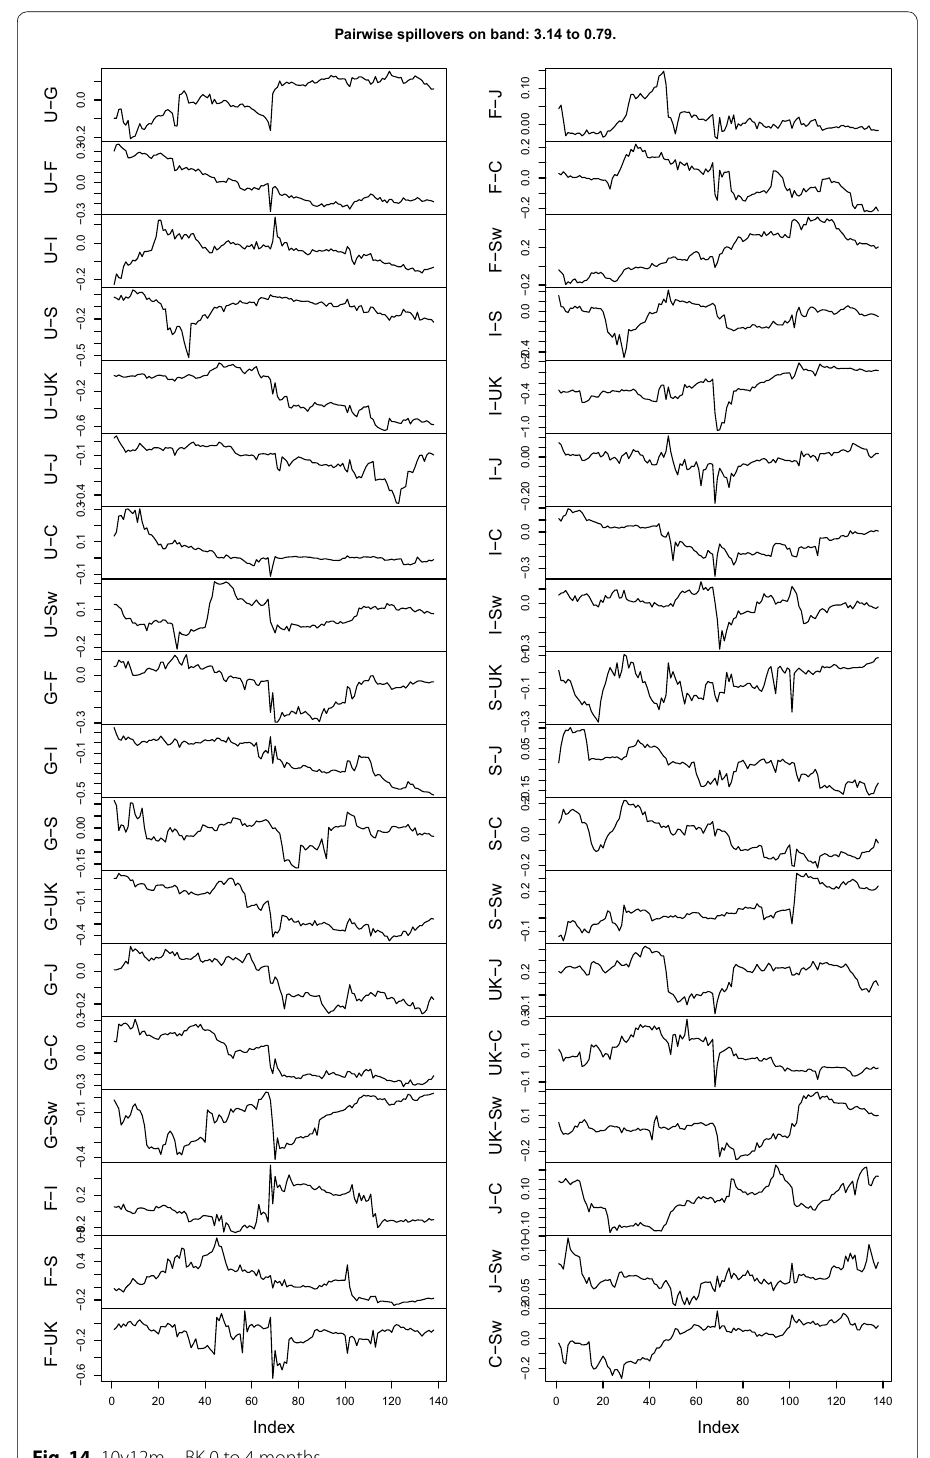
Fig. 14 10y12m—BK 0 to 4